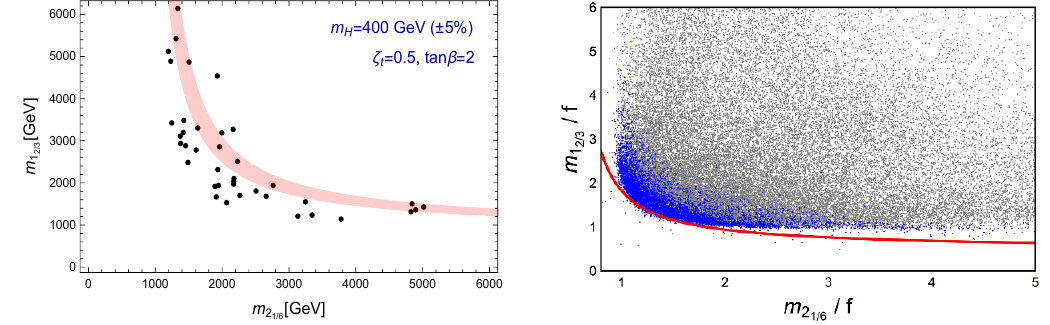
Figure 7 . Distribution of the masses of the lightest top-partners. (Left) Zoomed region of a selected mass window for the heavy CP-even Higgs boson. The red shaded region represents the analytic formula for m H at O ( (cid:24) ). (Right): the blue points are subject to the constraint tan (cid:12) < 0 : 1 and the red line is the theoretical expectation for the Higgs mass in the minimal